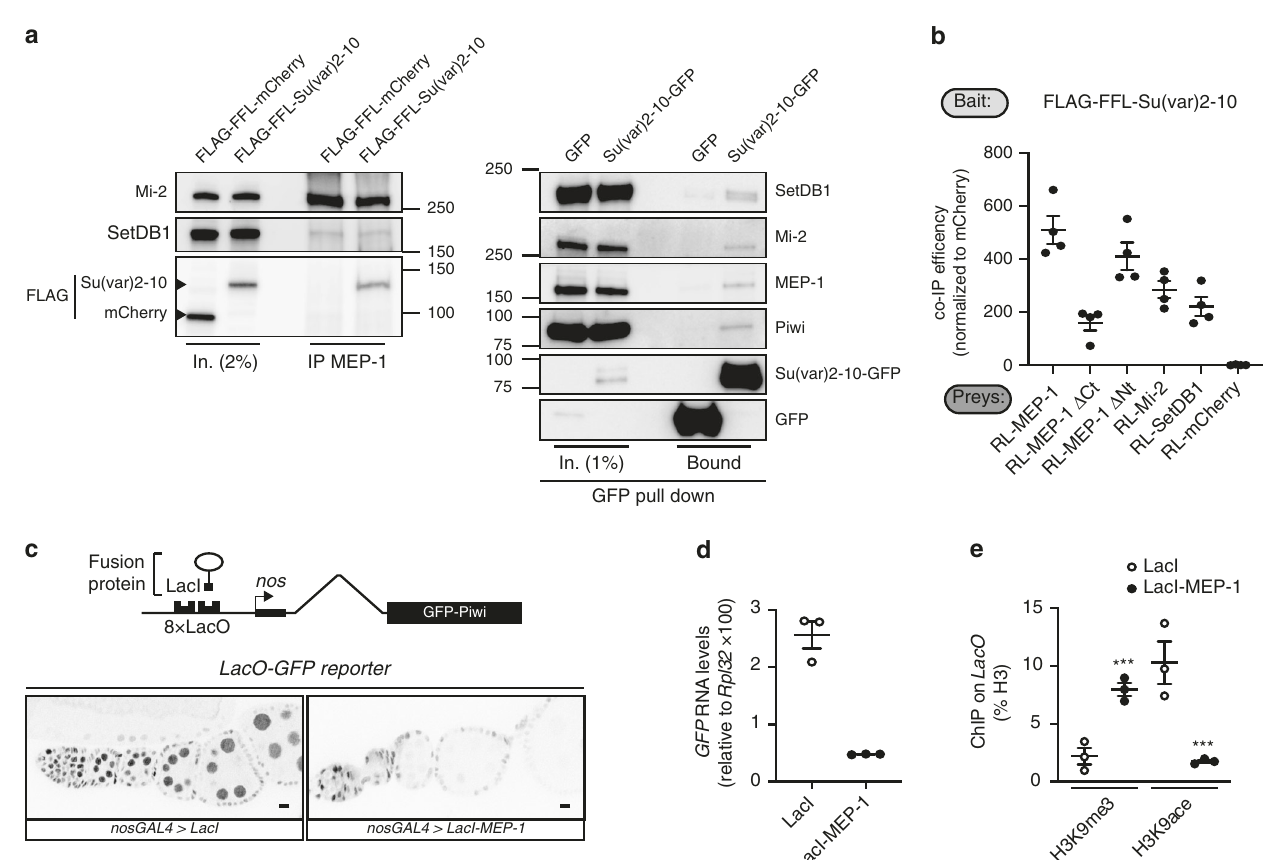
Fig. 6 MEP-1 interacts with Su(var)2-10 and induces transcriptional silencing upon recruitment to DNA. a Western blot analysis of co-IP of (left panel): MEP-1 in OSC nuclear extract expressing either FLAG-FFL-Su(var)2-10 or FLAG-FFL-mCherry as a negative control or of (right panel): GFP-Trap in OSC nuclear extract expressing either Su(var)2-10-GFP or GFP alone. b Graph shows the normalized co-IP ef fi ciency of several preys (MEP-1, MEP-1 Δ Ct, MEP- 1 Δ Nt, Mi-2, and the negative mCherry control) with the FLAG-FFL-Su(var)2-10 bait. Dots show values of n = 4 biologically independent samples, lines represent mean ± SEM. c Targeting MEP-1 to reporter DNA induces silencing in vivo. Schematic representation of the 8xlacO-GFP reporter. The lower panels show the GFP fl uorescence signal of LacO-GFP reporter in egg chambers that express the LacI (left) or LacI-MEP-1 fusion proteins (right) under the control of the germline-speci fi c nos-GAL4 driver. Scale bars, 10 μ m. d Dots showing quanti fi cation of eGFP RNA levels in ovaries that express LacI or LacI- MEP-1 under the control of the germline-speci fi c nos-GAL4 driver. RNA levels are relative to RpL32 level. Mean values ± SEM of n = 3 biologically independent samples are represented. e Comparison of H3K9me3 and H3K9ace amounts on the LacO-GFP reporter, expressed in percentage of immunoprecipitated H3, in ovaries that express LacI or LacI-MEP-1 fusion proteins. P -values were calculated using sample data that displayed normal distribution (tested with the Shapiro – Wilkinson test). Variance homogeneity was tested with the Levene ’ s test and then the two-tailed Student ’ s t -test was used. *** P -value < 0.05. Mean values ± SEM of n = 3 biologically independent samples are represented. Source data for b , d , e : Supplementary Data set 6 and Supplementary Table 2 for e ; uncropped blot images are provided in Supplementary Data set